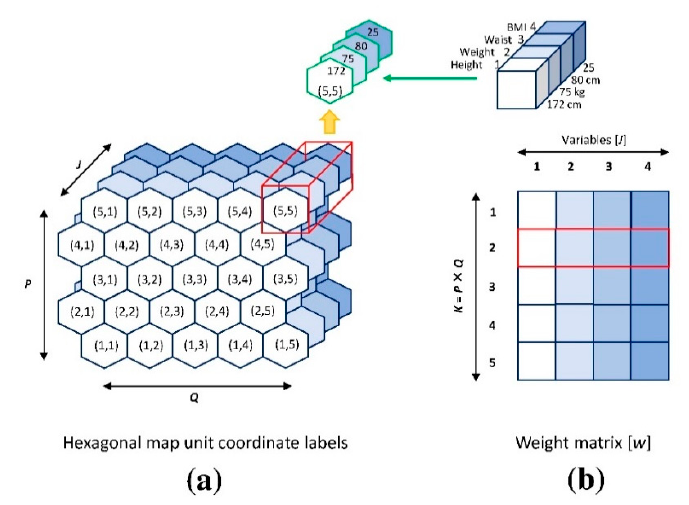
Figure 1. ( a ) Hexagonal map unit coordinate labels and ( b ) weight matrix.